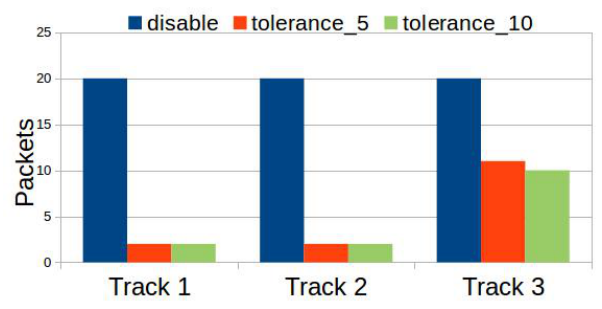
Figure 13. Network traffic with/without in-node analysis of redundancy with two different